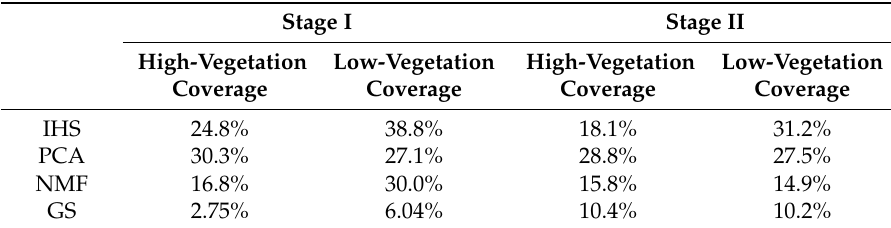
Table 13. Percent improvement in SD.